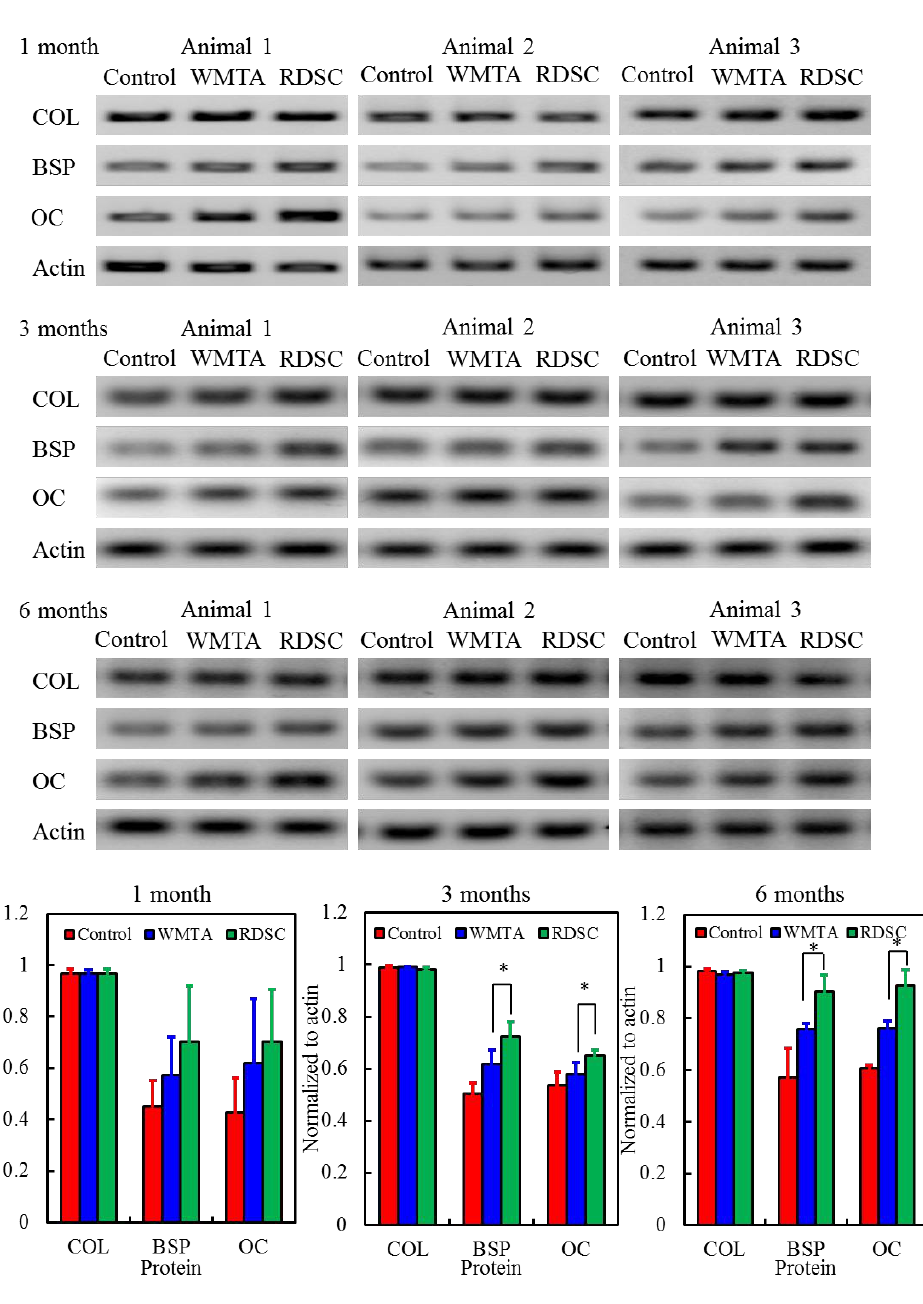
Figure 5. The bone-related protein expression of collagen type (COL), bone sialoprotein (BSP), and osteocalcin (OC) levels normalized to actin for bone tissue by Western blotting after 1, 3, and 6 months of implantation. It can be clearly seen that BSP and OC levels were higher in cells surrounding the RDSC cement specimens than in cells for the WMTA after three and six